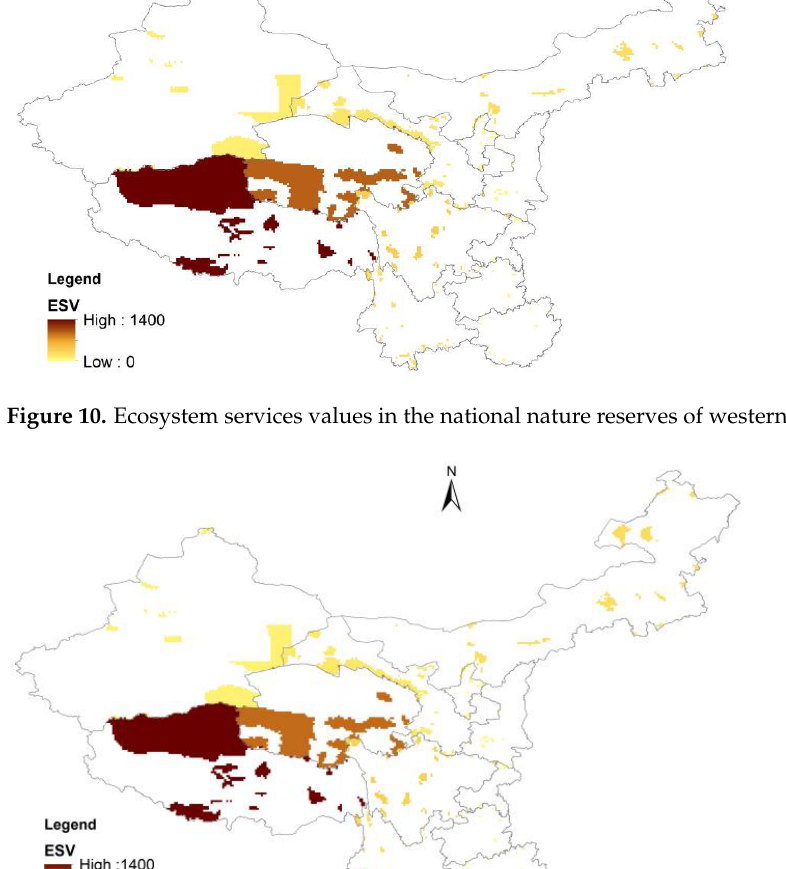
Figure 11. Ecosystem services values in the national nature reserves of western China in 2010.